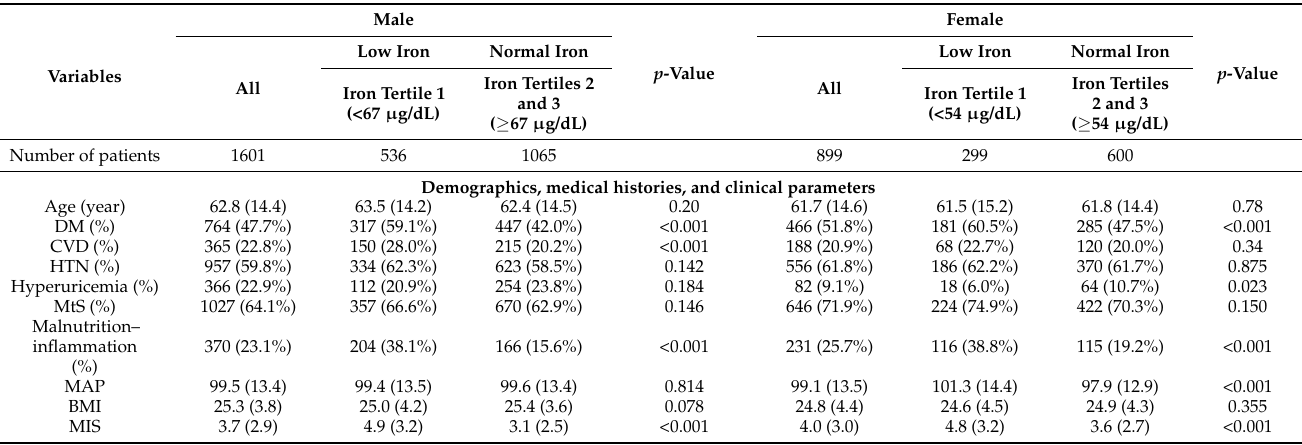
Table 1. Baseline characteristics of chronic kidney disease stage 1–4 patients divided by sex and serum